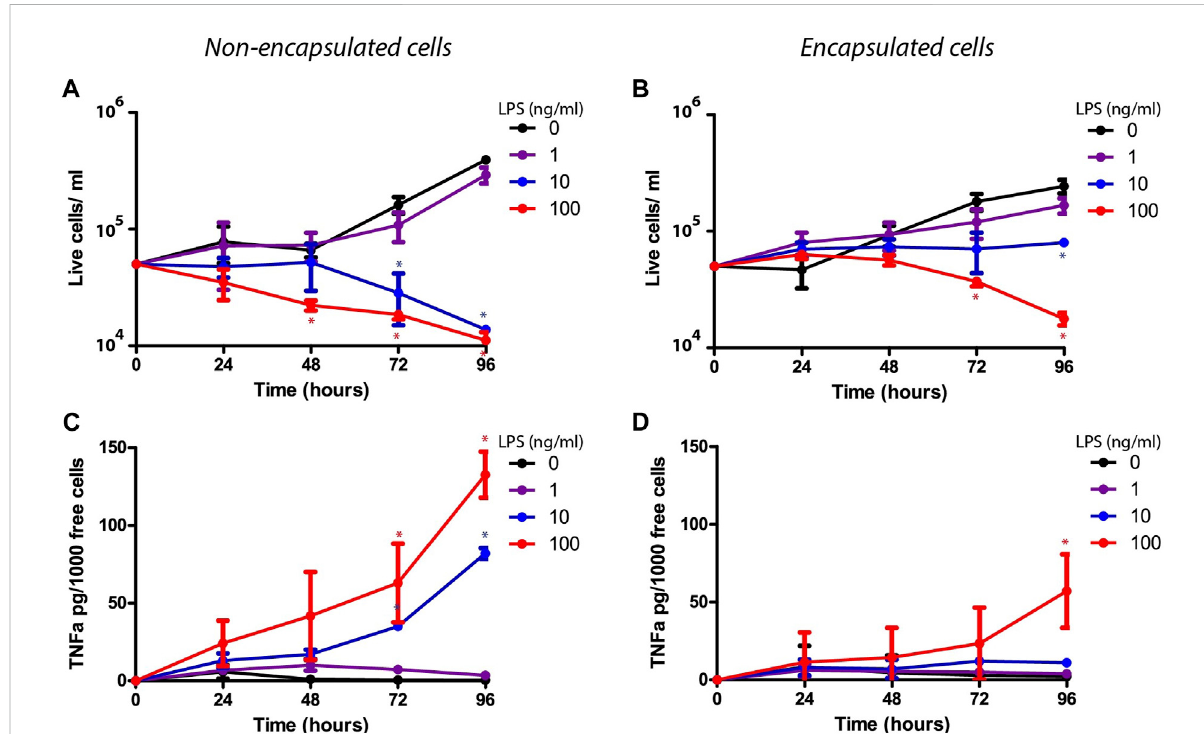
FIGURE 3 The effect of LPS on TNF α secretion by encapsulated vs. non-encapsulated macrophages. (A,B) Concentrations of free (non-encapsulated) (A) and encapsulated macrophages (B) in 24-well plates over time after exposure to 1, 10, 100 ng/ml LPS (purple, blue and red line) or none (black line). (C,D) AmountsofTNF α secretionper1,000freemacrophagesandencapsulatedmacrophagesafterLPSstimulationafterexposuretoLPS.* p value < 0.05 tested in Wilcoxon non-parametric